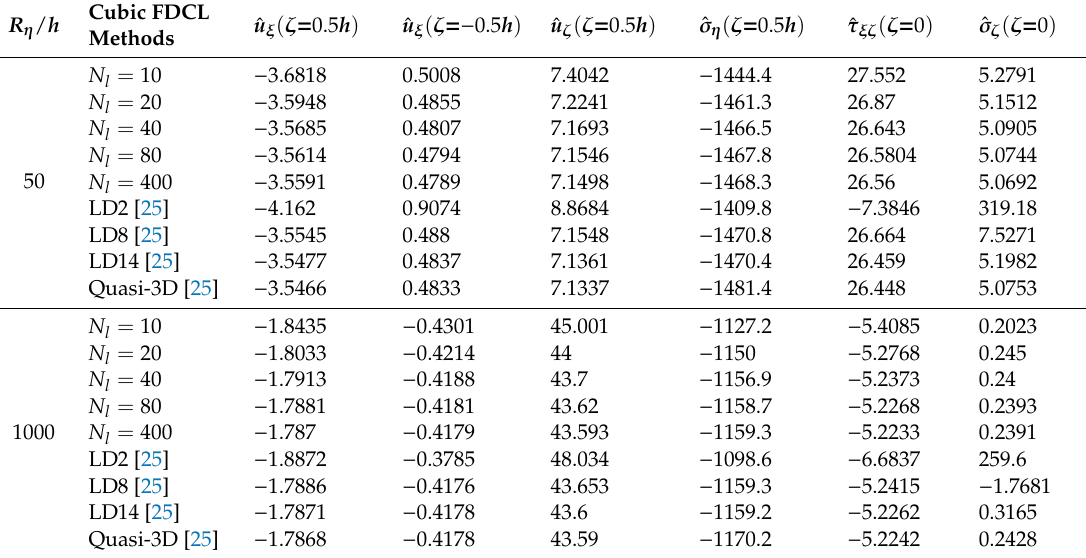
Table 2. Results of cubic FDCL methods for various field variables induced in a single-layered FGDC shell under a thermal